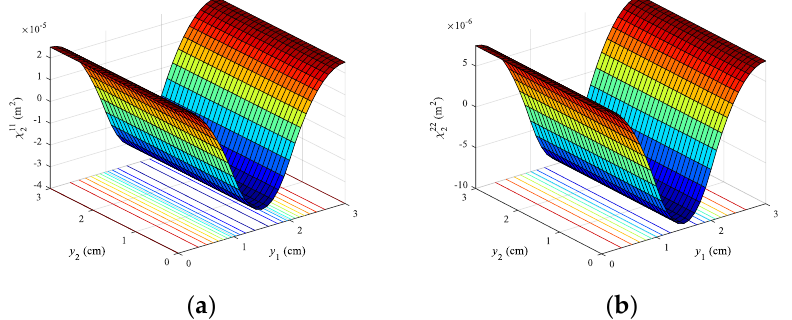
Figure 11. Second-order influence function 𝝌 2 of the CFCF periodic layered plate. ( a ) 𝑚𝑛 = 11 ; ( b ) 𝑚𝑛 = 22 .